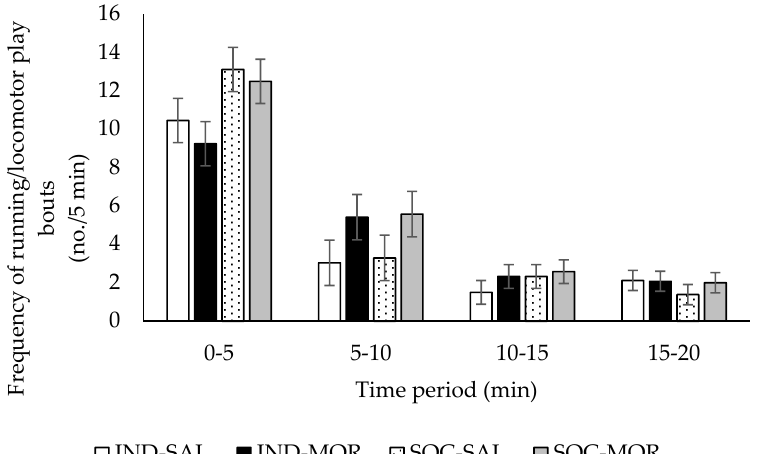
Figure 2. Frequency of running/locomotor play bouts (no./5 min; Least square means ± SEM) performed by calves during a 20 min observation period in an arena test. Calves received an injection of saline and were tested individually (IND-SAL, n = 12) or in pairs (SOC-SAL, n = 12), or received an injection of morphine and were tested individually (IND-MOR, n = 12) or in pairs (SOC-MOR, n = 12). The frequency of total individual play events was affected by treatment ( F (3,29) = 3.101, p = 0.042; Figure 3), but there was no significant treatment by time interaction ( F (9,120) = 1.563, p = 0.134). Over the entire 20 min arena test period, the frequency of total individual play events did not differ ( p > 0.05) between calves given morphine or saline when tested individually or when tested in pairs, however, calves given morphine and tested in pairs performed fewer ( p < 0.05) individual play events than calves given morphine and tested individually. Overall, individually tested calves performed more total individual play events than calves tested in pairs (total individual play events (no./5 min): IND: 5.3 ± 0.54; SOC: 3.7 ± 0.54, F (1,29) = 9.230, p = 0.005), but there was no difference between calves given saline or morphine (total individual play events (no./5 min): SAL: 4.6 ± 0.54; MOR: 4.4 ± 0.54, F (1,29) = 0.168, p = 0.685).